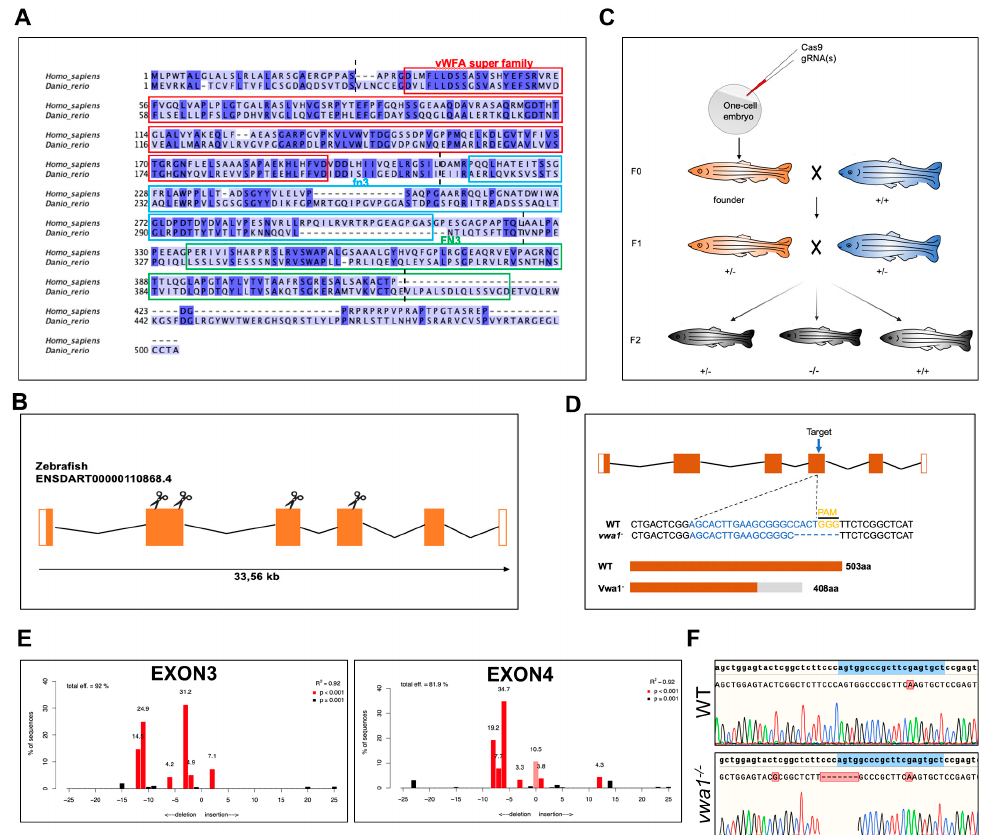
Figure 1. Conservation of vwa1 across species and generation of vwa1 knockout zebrafish by CRISPR/Cas9 genome editing. ( A ) Multiple sequence alignment of amino acids for human (445 aa) and zebrafish (503 aa) VWA1. Identical amino acids are shaded blue. The von Willebrand factor A-domain (vWFA), first fibronectin type III repeat domain (fn3), and second fibronectin type III repeat domain (FN3) are marked with red, blue, and green boxes, respectively. The boundaries between exons are marked with black dashed lines. ( B ) Structure of exons and introns of zebrafish vwa1 . Untranslated regions are represented by white boxes, and coding regions are represented by orange boxes. Scissors indicate the position of the four CRISPR guides used to generate vwa1 -KO crispants. ( C ) Stepwise construction of mutants. Adult F0 zebrafish were outcrossed with WT zebrafish, and their offspring were genotyped by PCR and Sanger sequencing to identify germline transmission of the vwa1 deletion (F0 founders). A selected F0 founder was then crossed with WT zebrafish to obtain F1 heterozygotes, which were inbred to obtain F2 homozygous mutants. ( D ) Detailed illustration of mutant line generated by targeting exon 4. ( E ) Validation of the efficiency of gRNAs. Validation of the second gRNA targeting exon 2 failed owing to its intron-adjacent location. ( F ) Schematic diagram and sequencing results for WT controls and the vwa1 mutant line in the F2 generation generated by CRISPR/Cas9 technology. Lower panel shows the target sequence (blue), protospacer adjacent motif (PAM) sequence (yellow), and 7-bp deletion in the mutant line.